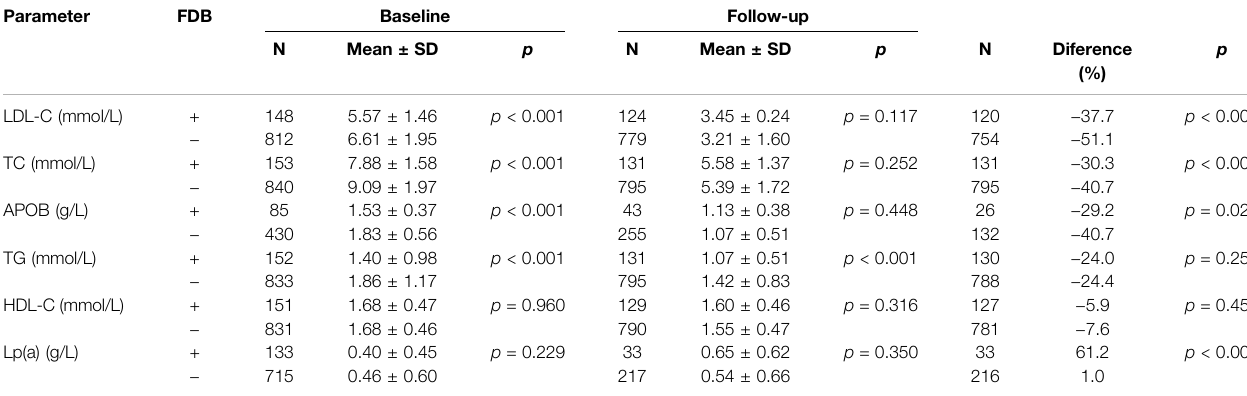
TABLE 5 | FDB and non-FDB patients and effect of treatment on lipid levels.